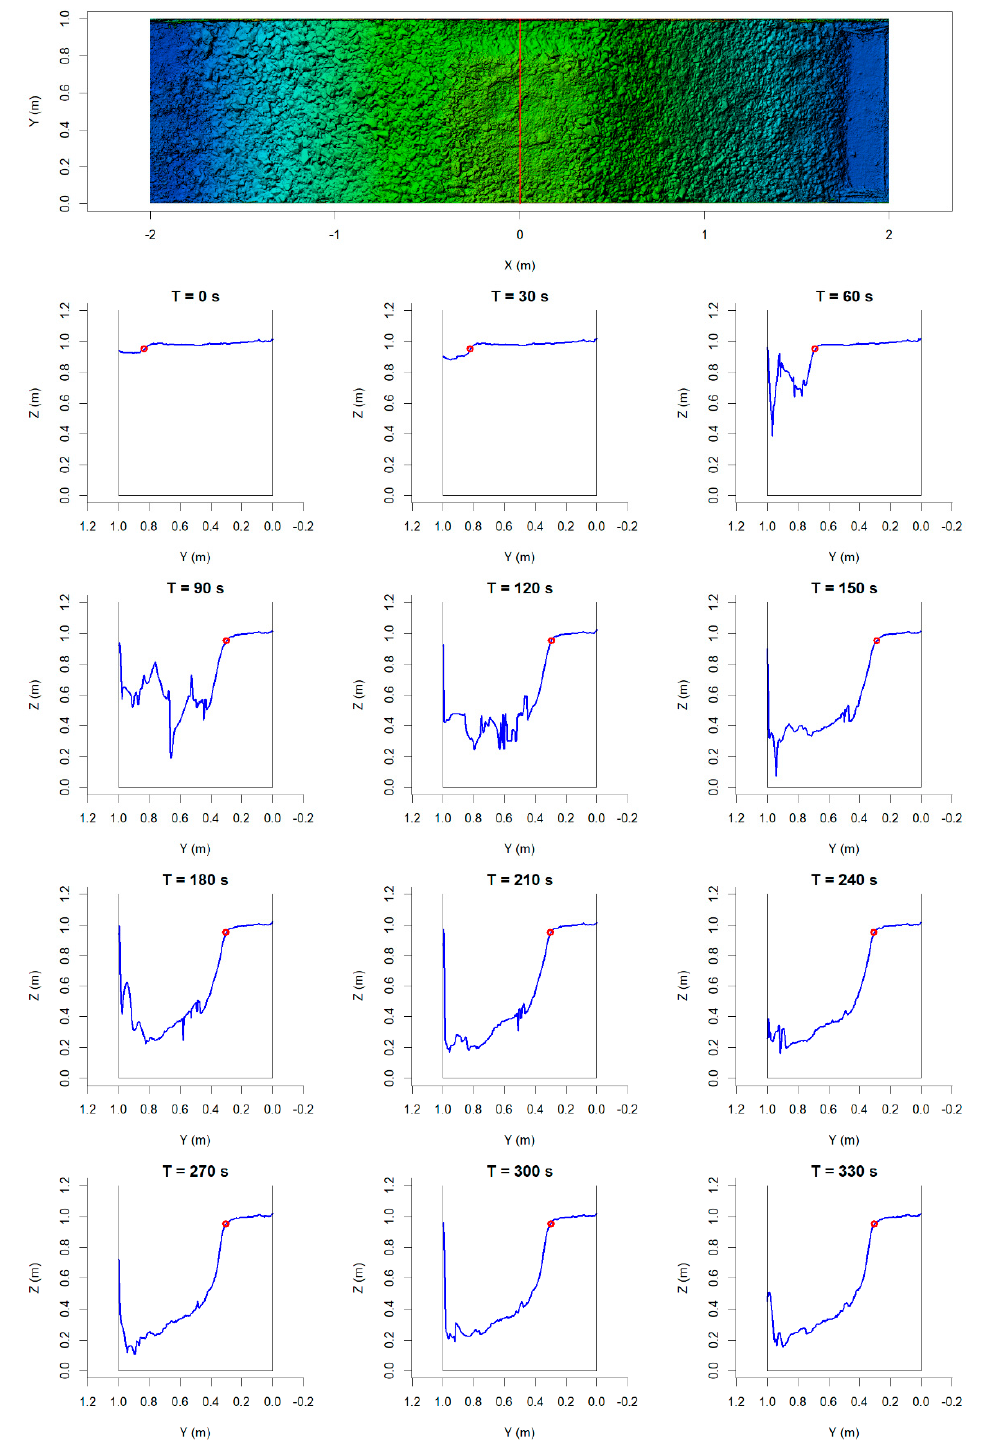
Figure A3. Cross-section profiles for X = 0 m (centre line) extracted from U3 dynamic 3D model; T = 0 s is immediately before initial observed erosion at downstream edge of crest; red circle indicates breach edge as used in further analyses.